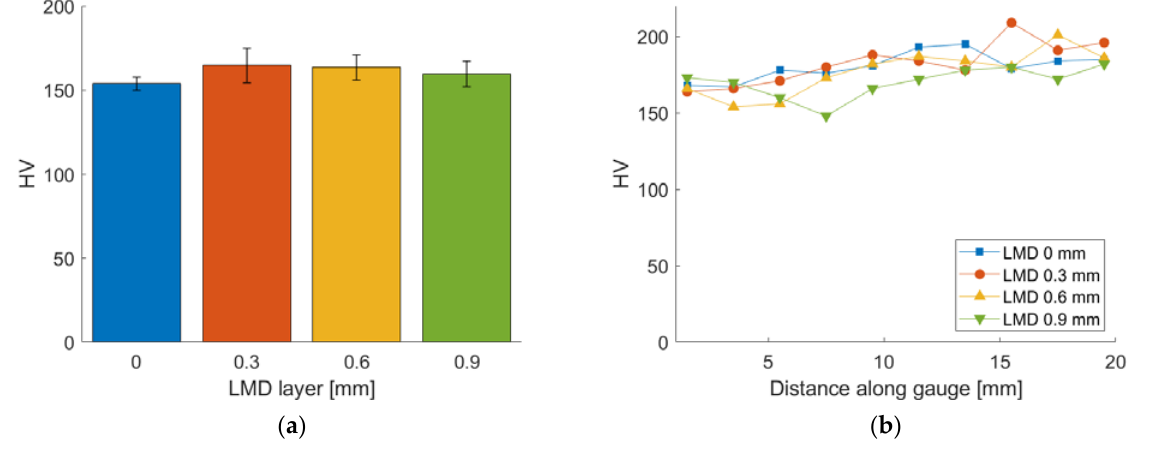
Figure 19. Vickers microhardness results: ( a ) In-plane microhardness of added LMD layer; ( b ) Microhardness along gauge length of fractured tensile specimens.